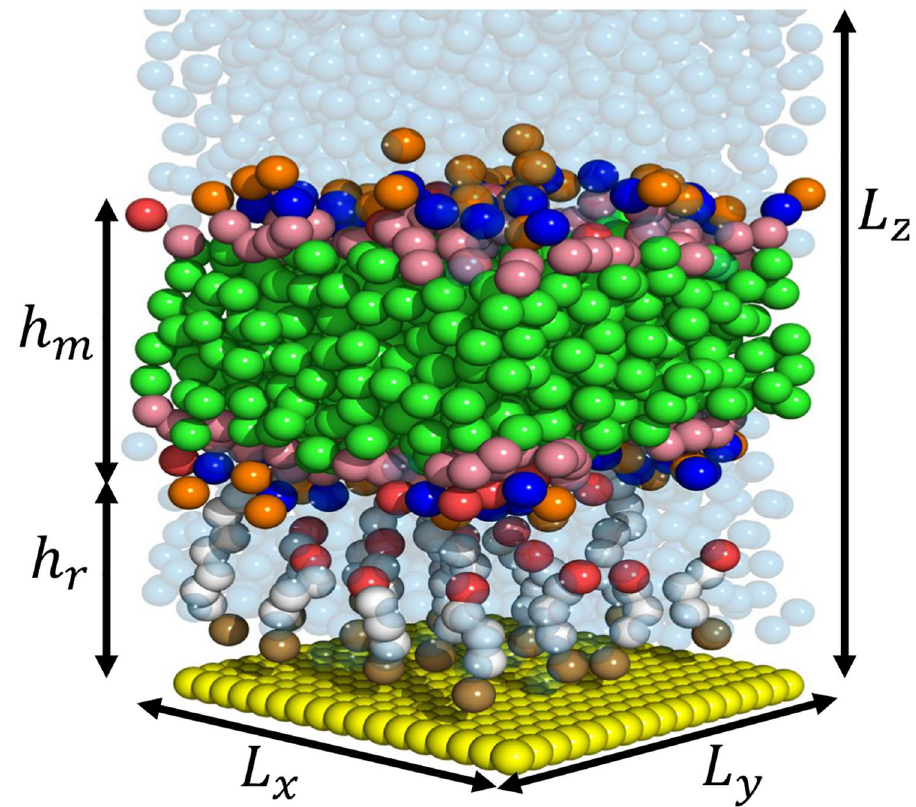
Fig 1. Schematic of the CGMD model of the tethered bilayer lipid membrane. The green beads represent the phytanyl tail of the GDPE and DphPC lipids, NC 3 bead is displayedin blue, the PO 4 bead in orange, OH bead in red, the COC bead as pink, polyethylene glycol beads as white, benzyl disulphidebead as brown, gold beads as yellow, and the water beads as a translucent blue. L z is the height of the simulation cell, L y and L x are the length and width of the simulationcell, h r is the tethering reservoir height, and h m is the membrane